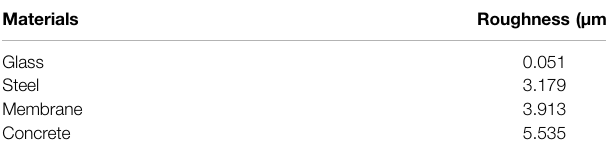
TABLE 1 | Roughness of the considered roo fi ng